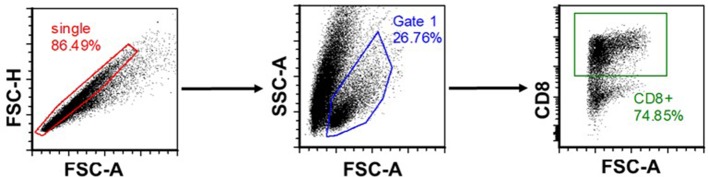
Gating strategy.Initially, non-single cells were excluded using FSC-A and FSC-H axes. Then, based on the morphology of the cells in the FSC-A SSC-A axes, the live cell population was gated. In this population, only cells that stained positively for CD8+ expression were subjected to further analysis.